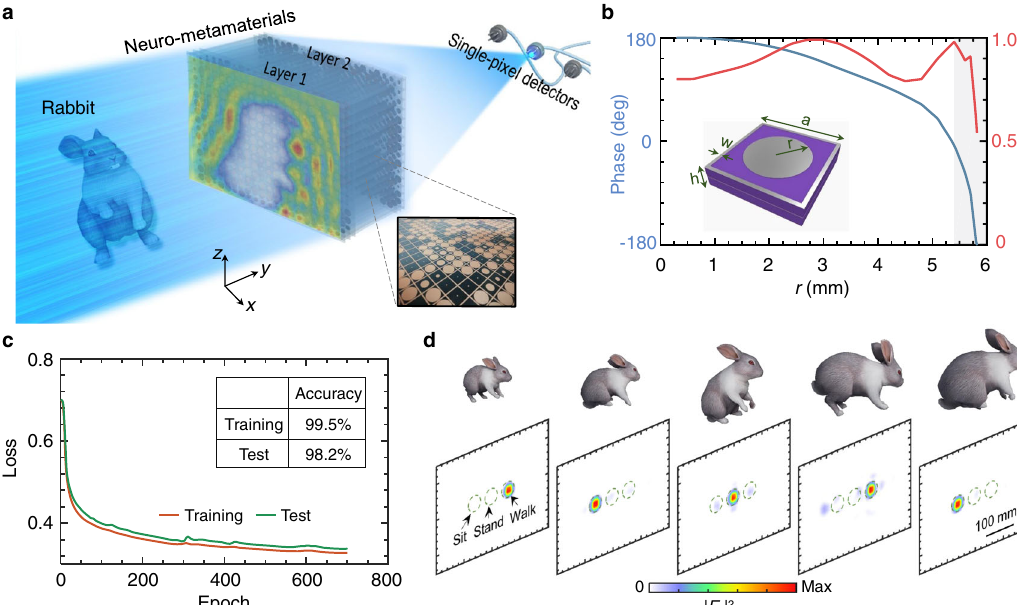
Fig. 2 Design of neuro-metamaterials for recognition of a rabbit ’ s postures. a A rabbit freely plays in front of the specially-designed neuro-metamaterial, the scattered waves of which focus on different pre-de fi ned pixels; see experimental setup in Supplementary Note 3. b Dispersion relation of the neuro- metamaterials. We deploy a polarization-insensitive composite unit cell patterned with circular patches; the surrounding square ring can reduce multiple coupling effects 36 . The detailed geometrical parameters are a ¼ 13mm ; w ¼ 0 : 5mm ; h ¼ 3mm, and the relative permittivity of the F4B substrate is 2.65. c The loss of the training and test sets vs. epoch. After hundreds of epochs, the neuro-metamaterials achieve an accuracy rate of 99.5% and 98.2% for the training and test set, respectively. d Numerical simulations of fi ve samples from the test set. In these samples, the rabbits differ in their size, posture, rotation angle, and distance to the neuro-metamaterials; see the inset pictures. Here, we judiciously de fi ne the optical recognition result (sit/stand/walk) to focus on one of the three positions